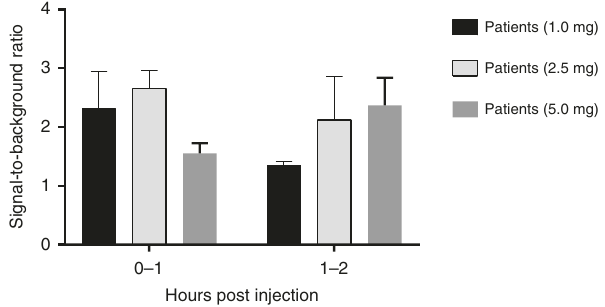
Fig. 3 Signal-to-background ratio (SBR) of the ureter. Note: the SBR of 5.0 mg is signi fi cantly lower than the SBR of 2.5 mg (unequal variance t test: p = 0.003) and 1.0 mg (unequal variance t test: p = 0.01) in the fi rst hour post dose. The values represent the mean ± SD ( n = 4 patients each